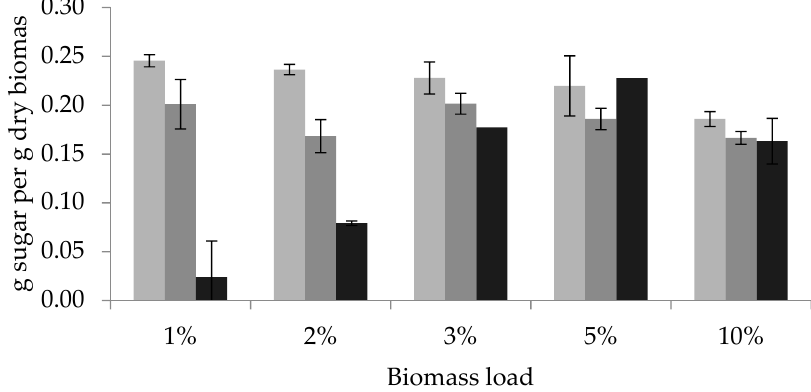
Figure 1. The effect of hay substrate solid loading on fermentable reducing sugar yield in batch-scale tests with enzymes from Irpex lacteus (light grey), enzymes from Trichoderma reesei (grey), and commercial enzymes without the presence of a non-biomass associated carbohydrate (black). All enzymes were added at 0.2 FPU/mL. Standard deviation represents the average from three separate test repetitions.